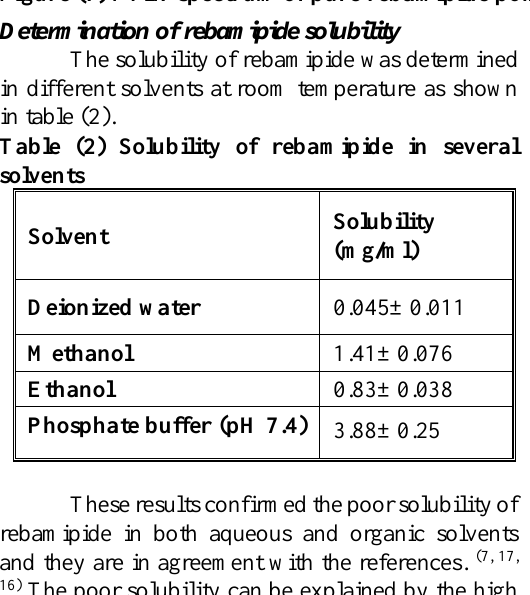
Figure (7) FTIR spectrum of pure rebamipide